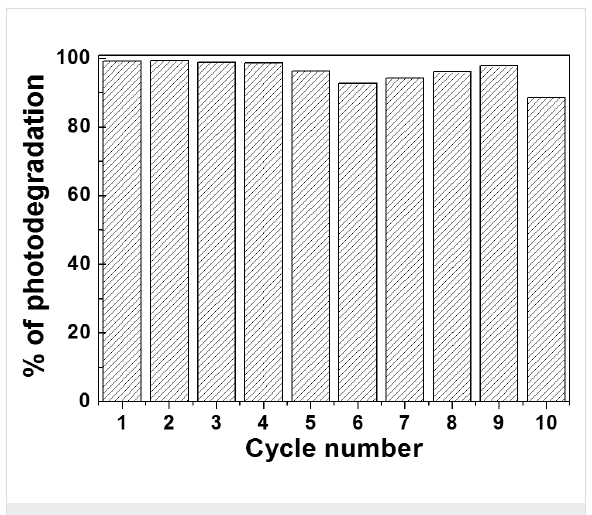
Figure 8: Recyclability of the ZnO/ZCIS